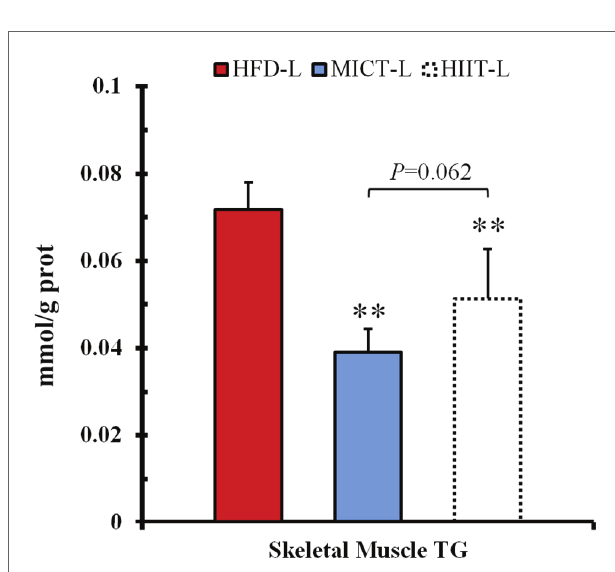
FIGURE 5 | Skeletal muscle triglyceride (TG) content. ** p < 0.01 vs. HFD-L. Values of p were calculated by one-way